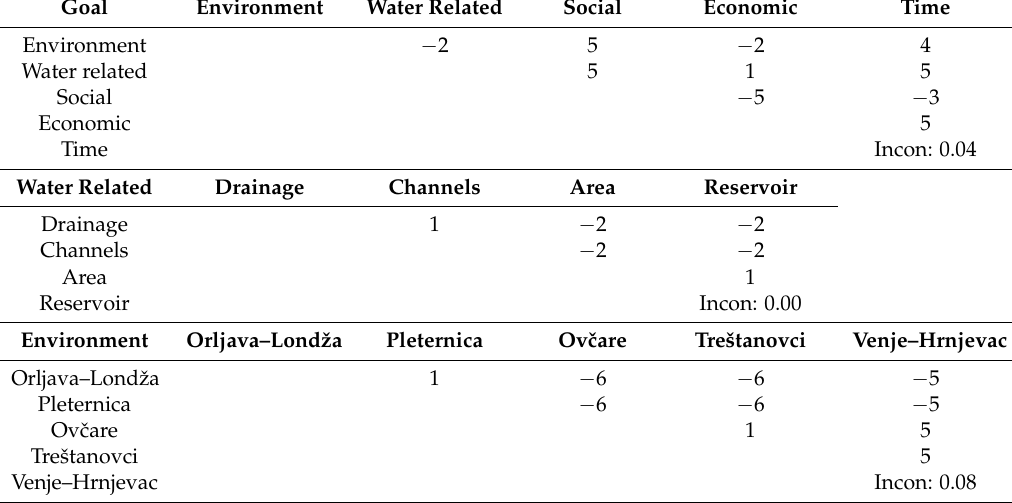
Table 6. Pair-wise assessment of: all groups of criteria in regard to the goal, all water-related criteria to the group criterion “water-related criteria”, and all alternatives to the criterion “environment” based on Scenario 1.